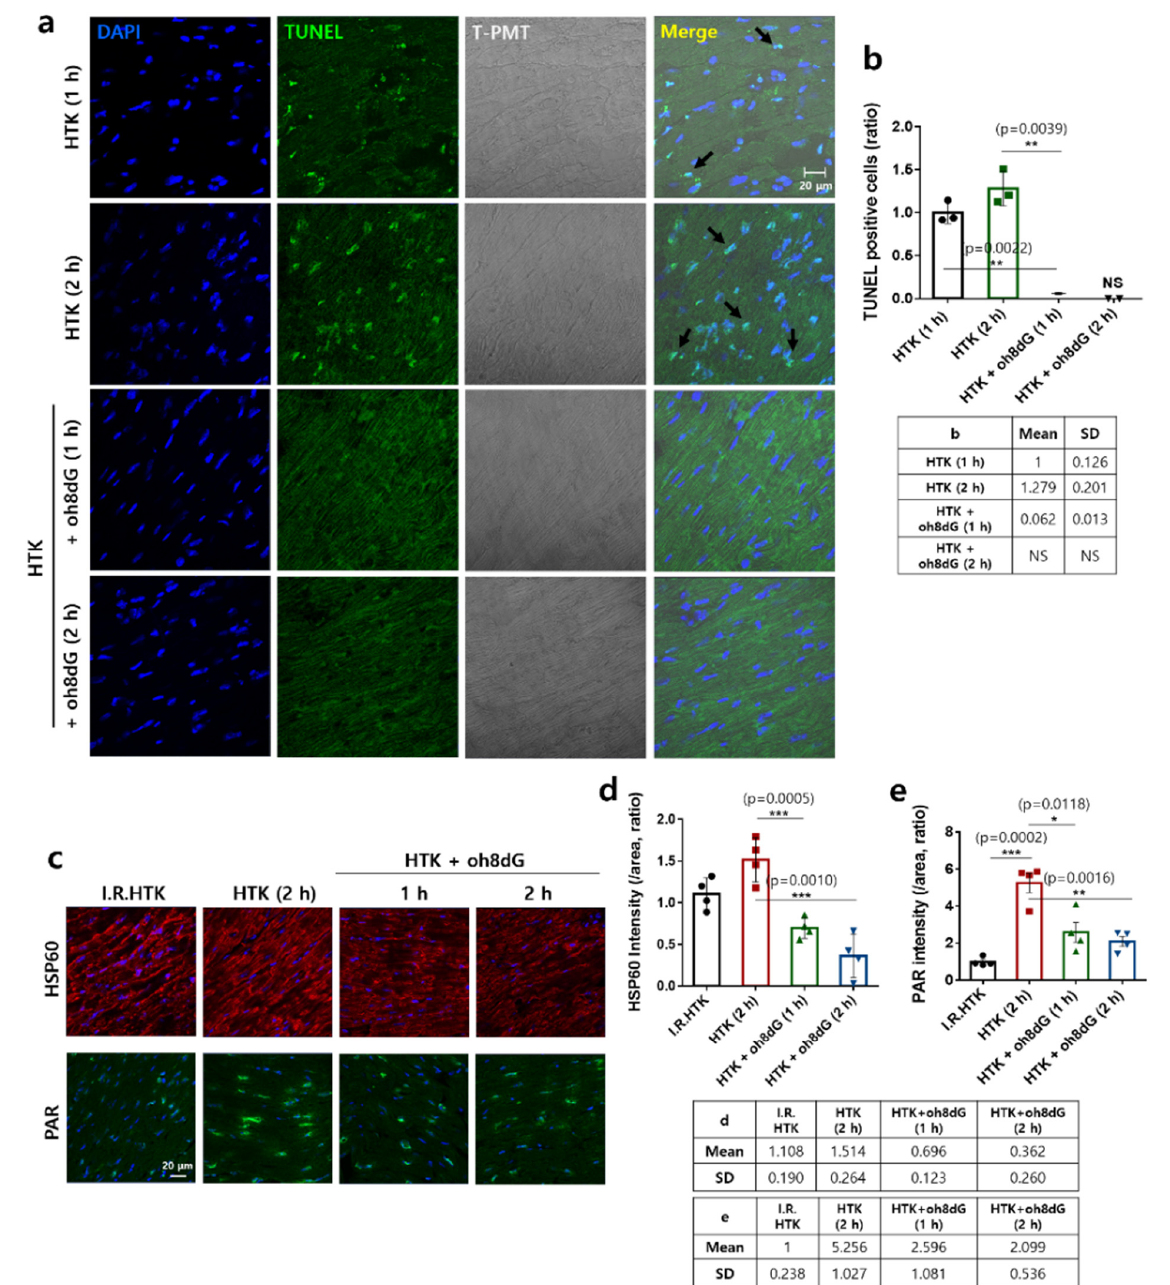
Figure 5. Treatment of oh8dG attenuated HTK-mediated cardiac destructive signals. ( a ) DNA fragmentation was measured by a TUNEL assay on the heart section of mice. The heart was treated with HTK solution for 1 h and 2 h, respectively, including 100 µ g/mL oh8dG at different times. Blue (DAPI, nucleus), green (TUNEL), and gray (T-PMT, tissue image). The scale bar represents 20 μ m. ( b ) Analysis of TUNEL positive cells (%) normalized by assessing total intensity/measuring area of FITC (green). Bars present mean ± SEM ( n = 3, * p < 0.05). NS; not significant. The table represents mean and SD value. ( c ) Immunostaining of HSP60 (red), PAR (green), and nucleus (DAPI, blue) in